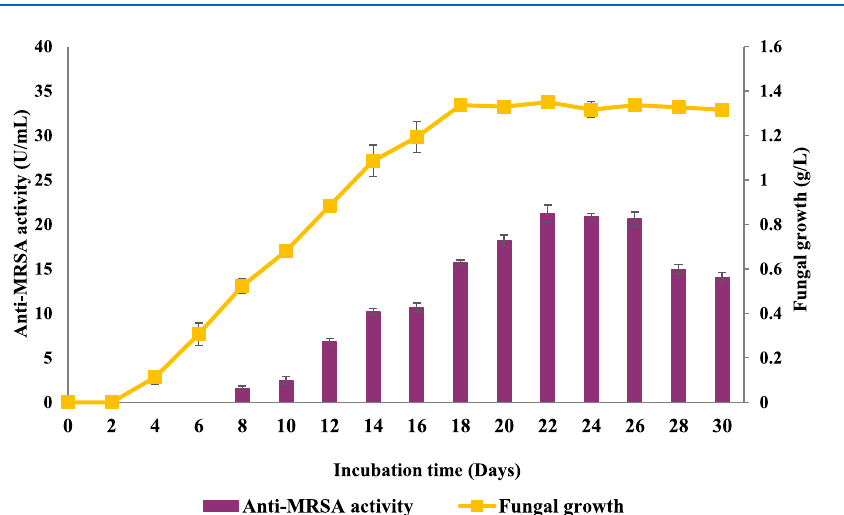
Fig. 1. Time course profile of anti-MRSA activity production and fungal growth of L. pseudotheobromae IBRL OS- 64 before improved conditions. Different letters indicate significant differences between means (Duncan, p<0.05). Standard deviation values of triplicate analyses are shown by error